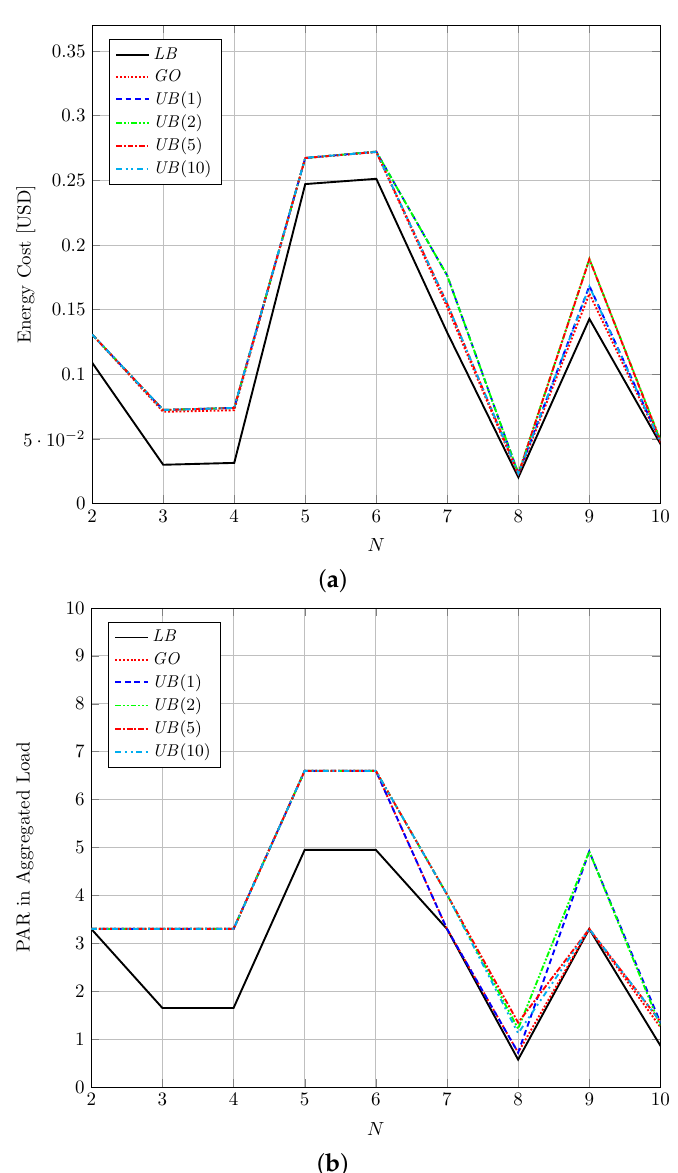
Figure 4. Comparison of upper (UB) and lower bounds (LB) with true values from global optimization (GO) in atomic energy consumption scheduling for ( a ) cost minimization and ( b ) peak-to-average ratio (PAR)